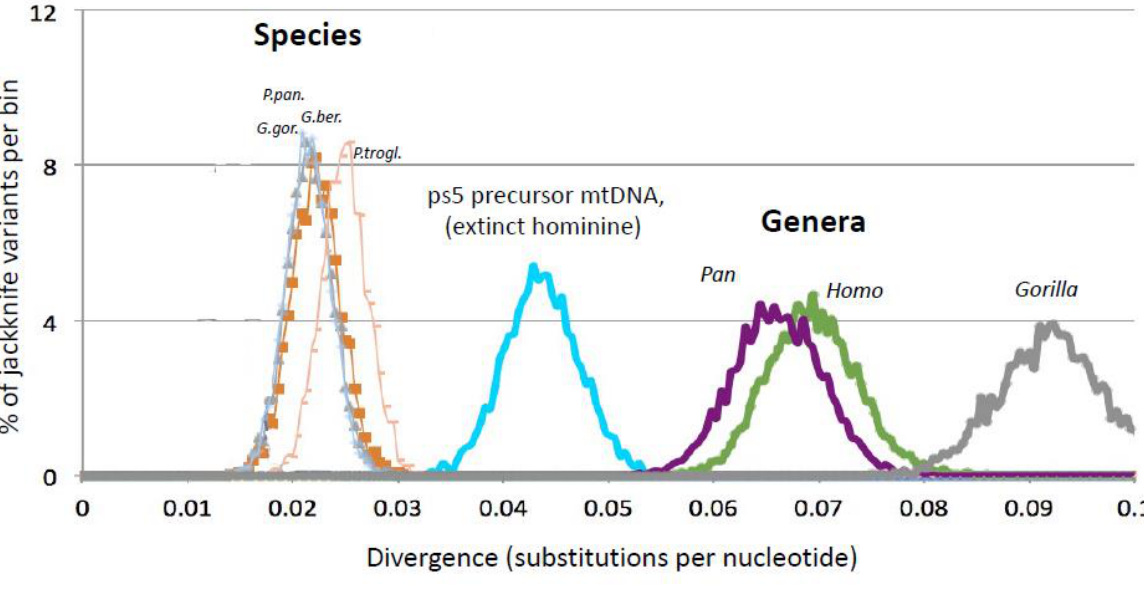
Figure 2. The divergence of hominine taxa from their common ancestors with sister taxa (a.k.a. branch lengths) is compared to the divergence of the ps5 precursor mtDNA (mtDNA of the hypothetical extinct Hominine) from its common ancestor with living hominines at the time of the ps5 formation (turquoise). Note that divergence of the ps5 precursor is intermediate between the divergences of congeneric species ( P. troglodytes and P. paniscus ; G. gorilla and G. beringei ) and the divergences of genera ( Homo and Pan ). Divergences were estimated from the common ancestor with a sister taxon (e.g., for Homo — from the common ancestor with Pan , for P. troglodytes — from the common ancestor with P. paniscus , and for Ps5 precursor mtDNA — from the common ancestor with the Homo-Pan-Gorilla clade). The curves represent the distribution of estimates by the jackknife procedure (Supplementary Note SN3); the ps5 data has been corrected by the fraction of mtDNA mutations in the ps5 stem (i.e., multiplied by 0.75, Supplementary Note SN5).